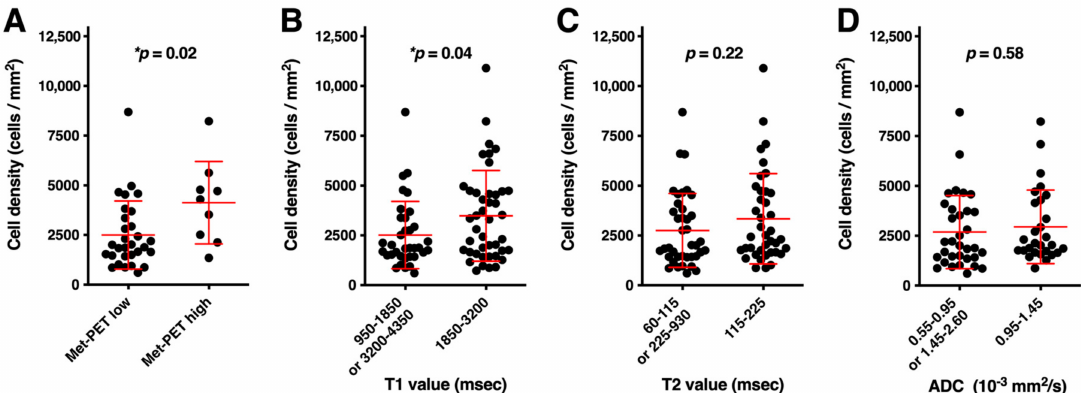
Figure 3. Correlation study between MET uptake, T1-, T2-relaxation times, ADC, and TCD. Cell densities, as measured in stereotactically sampled tissues, are plotted as a function of MET uptake ( A ), T1- ( B ), T2-relaxation time ( C ), and ADC ( D ). MET-PET and T1-relaxation time significantly correlated with TCD ( A , B ). Asterisk mark (*) indicates p < 0.05.